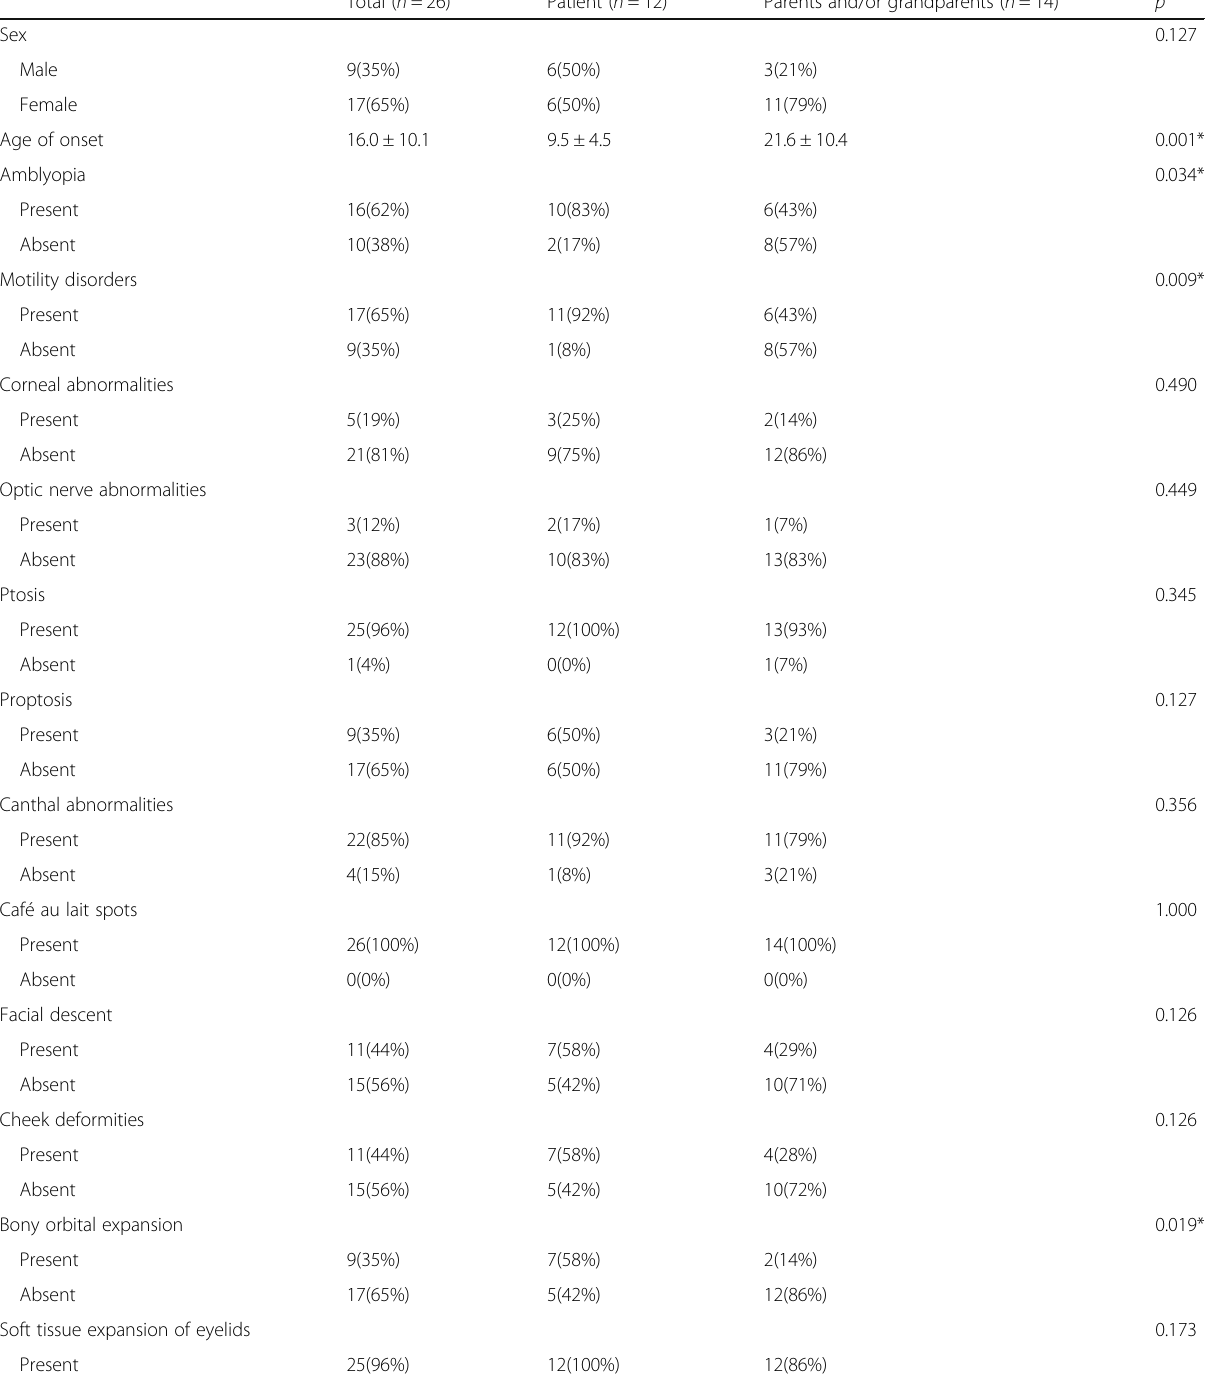
Table 1 Comparisons of demographic and clinical characteristics between the patients and affected members of the previous